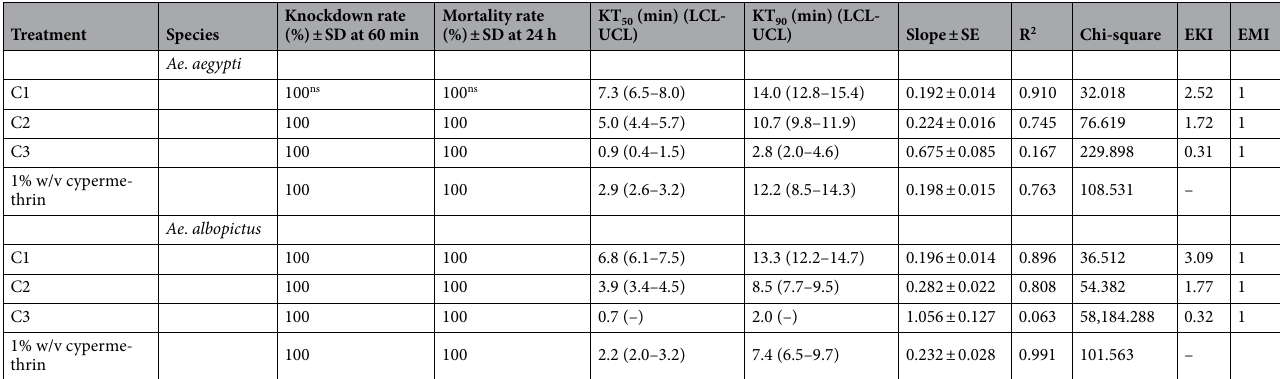
Table 4. Mortality rates (MR), increasing mortality value (IMV) and effective mortality index (EMI) of essential oils from C . verum , C . cassia , and C . loureiroi and their combinations against females of Ae . aegypti and Ae . albopictus . Mean percentage knockdown rates in each column followed by a different letter are significantly different (one way ANOVA and Duncan’s multiple range test, P < 0.05). IMV (%) Increasing Mortality Value, EMI Effective Mortality Index. Treatment codes are defined in Table 1.